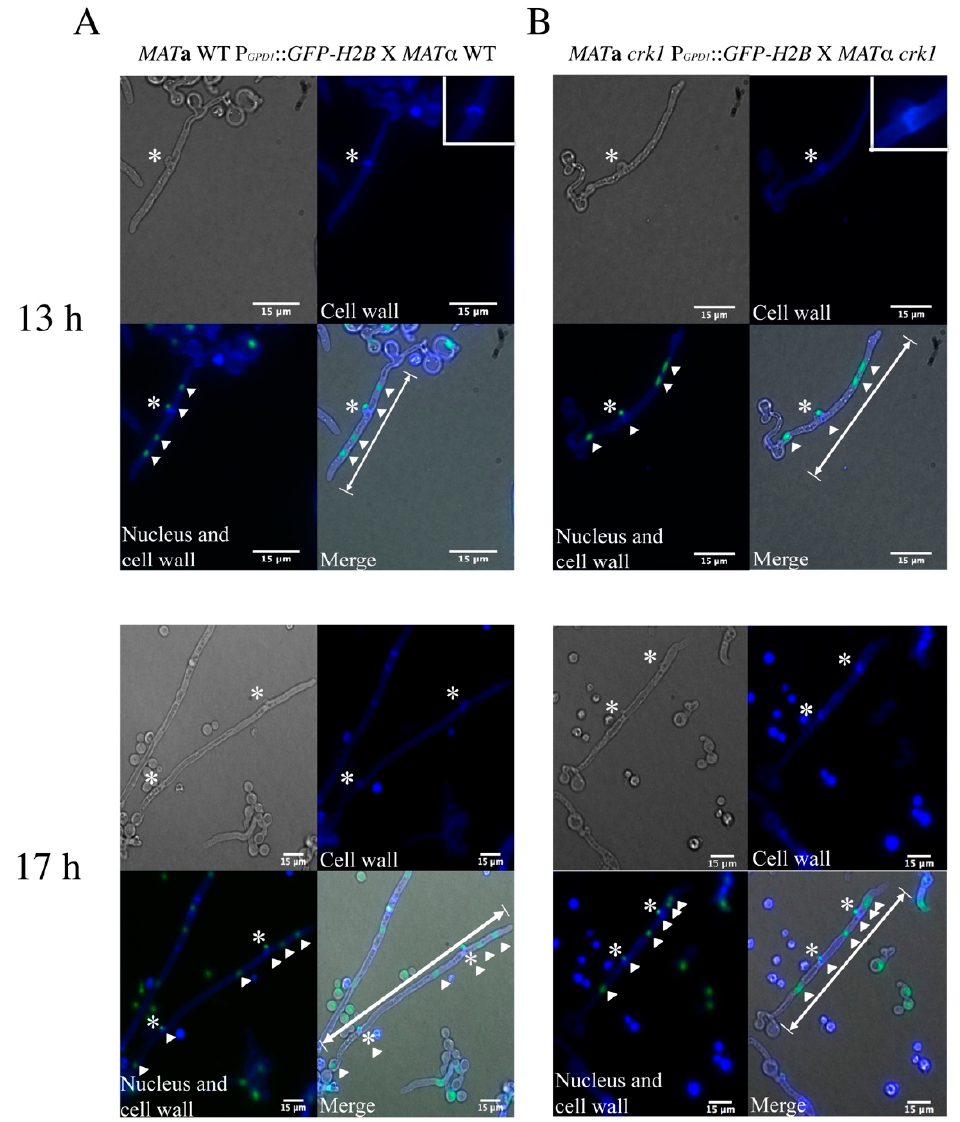
Figure 2. Morphology of dikaryotic filaments in the wild-type and bilateral crk1 mutant crosses. Mating mixtures of the wild-type ( A ) and bilateral crk1 mutant ( B ) crosses were incubated on SLAD medium containing 25 µg/mL calcofluor white and kept at 26 °C under dark condition. Nuclei were labeled by Gfp-H2b fusion protein. Cell wall was stained with calcofluor white. Dikaryotic filaments were photographed at 13 and 17 h post-incubation at 60× magnification. White star indicates clamp cell and white triangle marks nucleus. White double-headed arrow indicates the range of dikaryotic filament measurement. Scale bar = 15 µm.